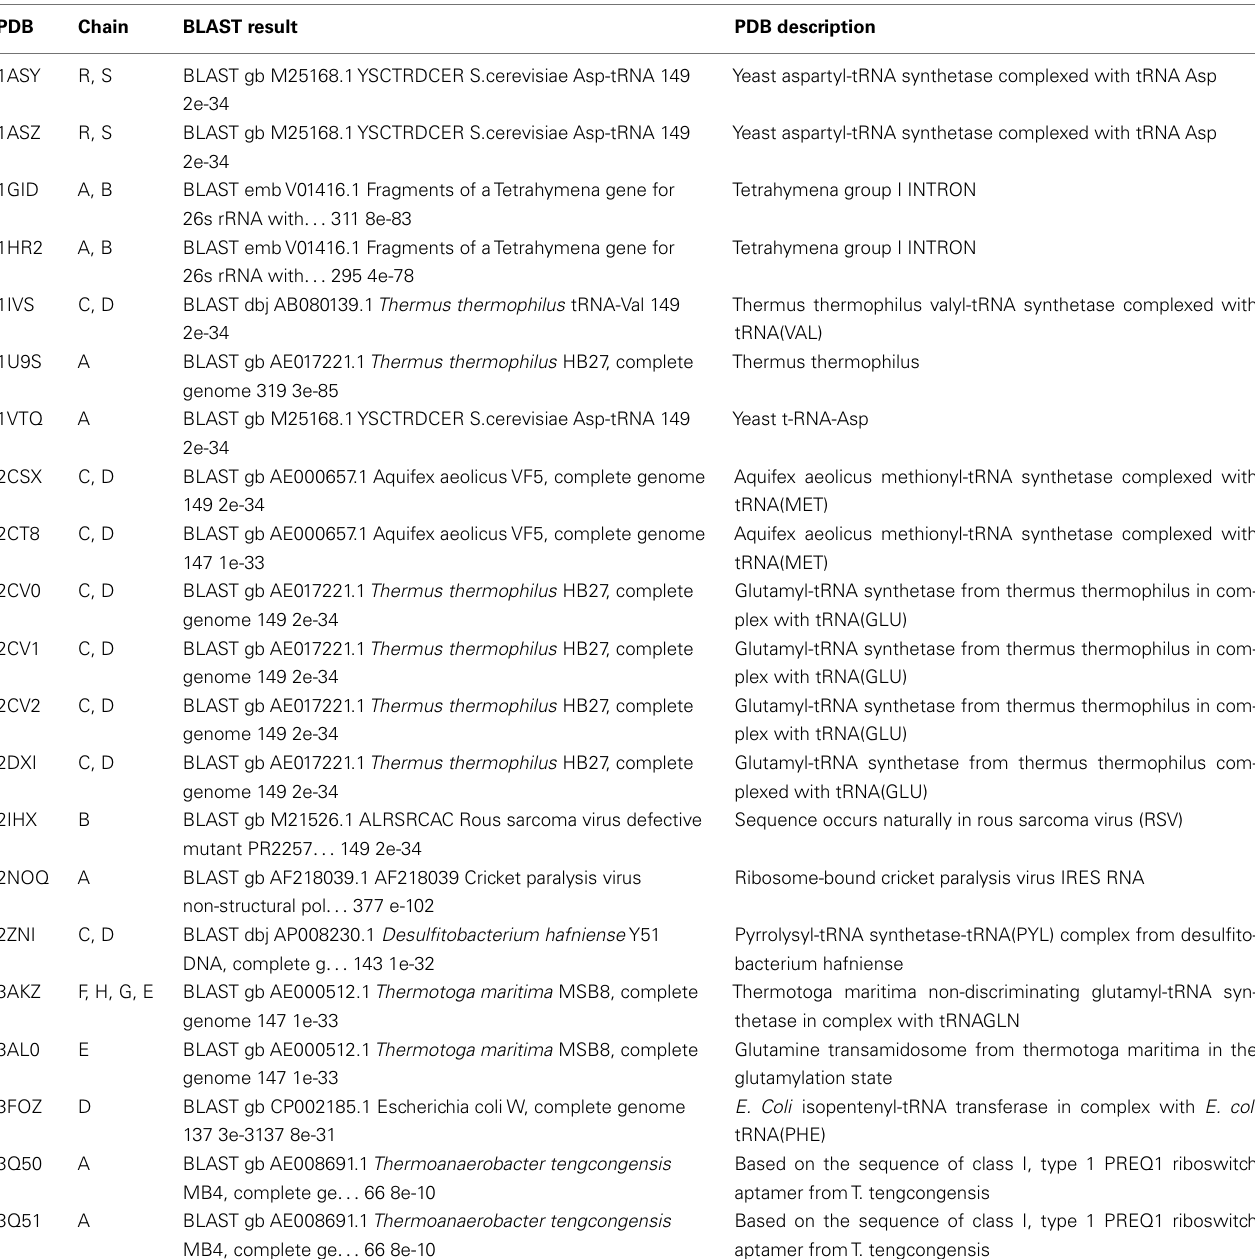
Table 2 |Validation of BLAST search